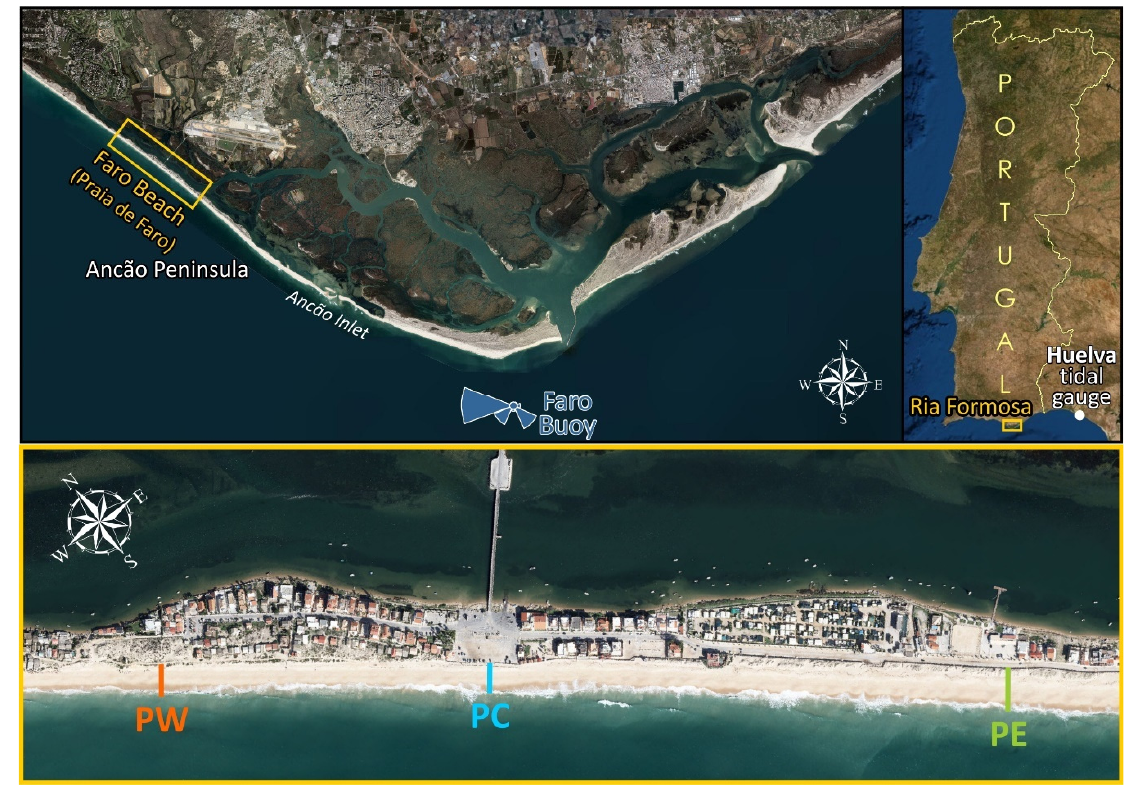
Figure 1. Location of Faro Beach (Praia de Faro) in the Ria Formosa system (top; Faro buoy is indicated in the image and the location of Ria Formosa and of the Huelva tidal gauge station are noted on the map, to the right) and of the 3 monitored profiles, PW, PC and PE (bottom).